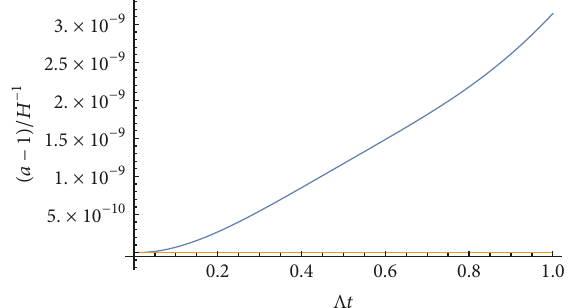
Figure 4: The correlation function ⟨